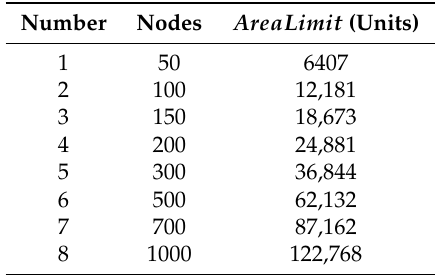
Table 1. The constraint values of eight different